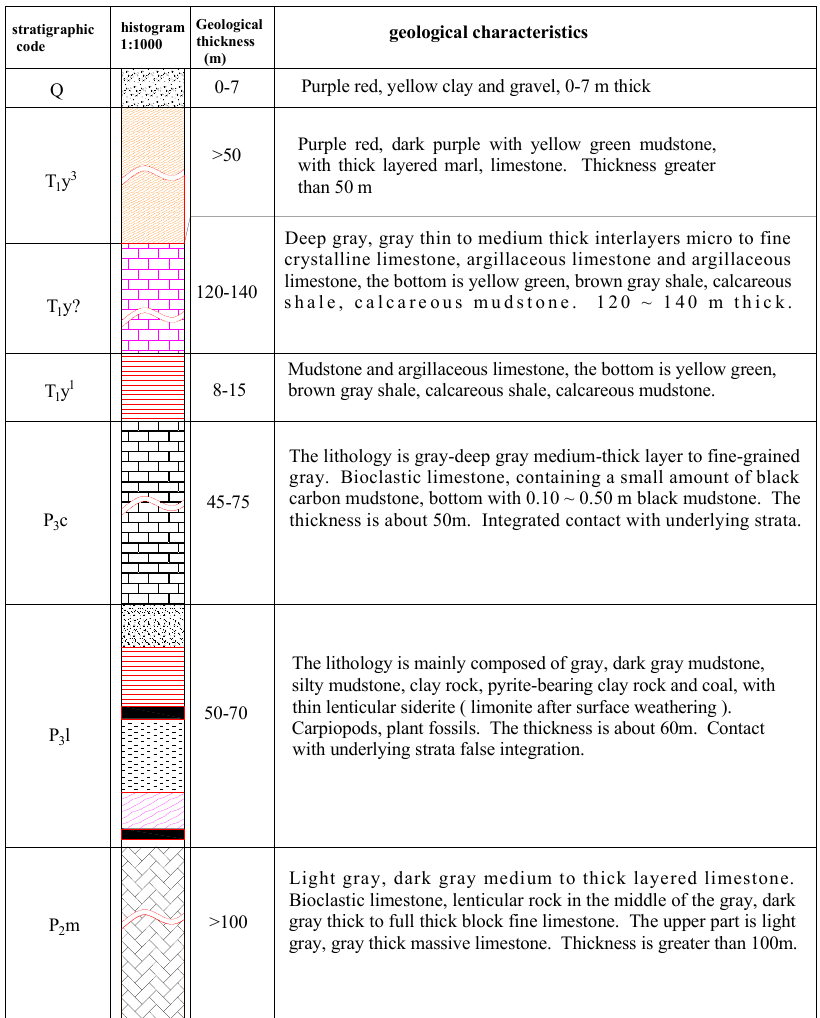
Figure 1. Comprehensive stratigraphic column map.